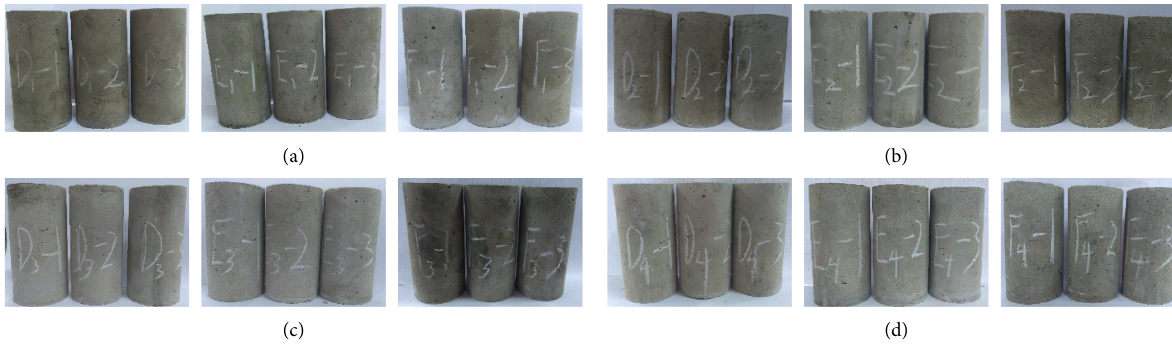
Figure 9: Reinforcing cement paste sample. (a) 7d age sample. (b) 14d age sample. (c) 21d age sample. (d) 28d age